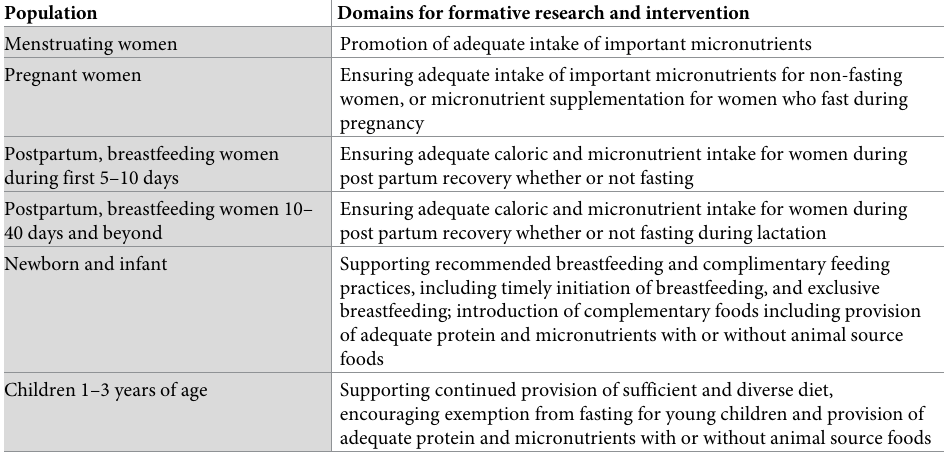
Table 3. Recommended domains of research for different fasting